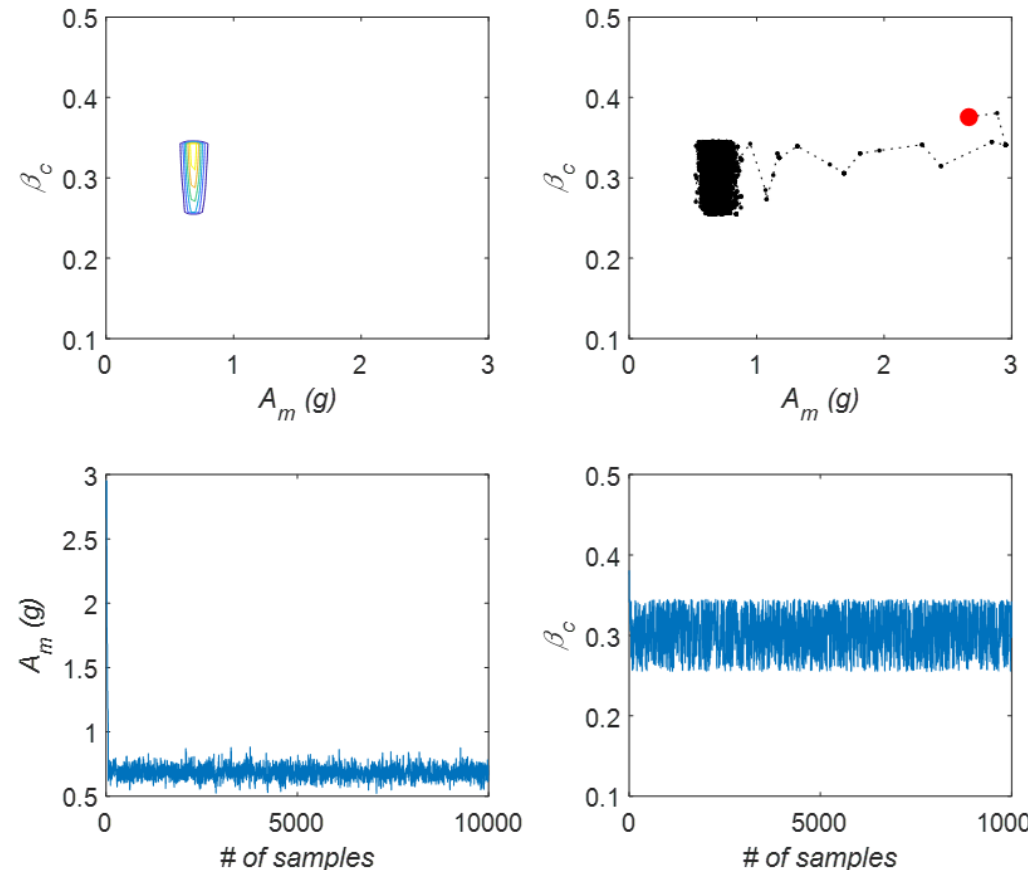
Figure 9. The posterior distribution of main parameters for piping seismic fragility curve (regarding the limit state of T104), and the related Markov Chain Monte Carlo (MCMC) sampling process. Appl. Sci. 2020 , 10 , x FOR PEER REVIEW Table 1. Comparison of the accuracy and the numerical cost for the piping seismic fragility curves according to two methods, i.e., incremental dynamic analysis (IDA)-based maximum likelihood estimation (MLE) method and the proposed method (Bayesian approach with the EPRI SOV method).